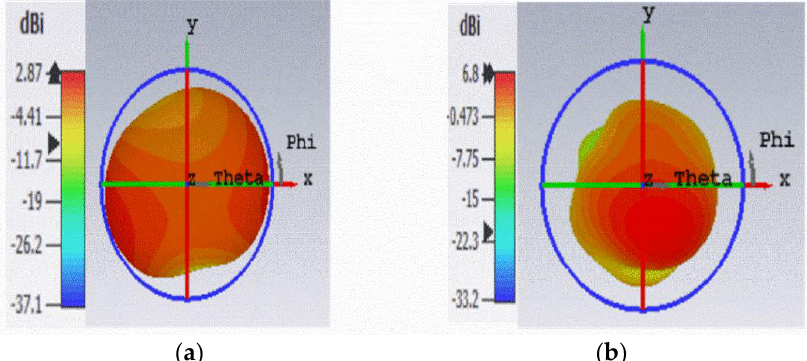
Figure 17. Simulated Gain of Antenna with AMC Backing, ( a ) at 0.915 GHz, ( b ) at 2.45 GHz. The simulated results of the antenna show that the gain had improved from 1.53 dBi to 2.87 dBi at 0.915 GHz, and 4.49 dBi to 6.8 dBi at 2.45 GHz, without affecting the bandwidth of the antenna, both with and without the AMC